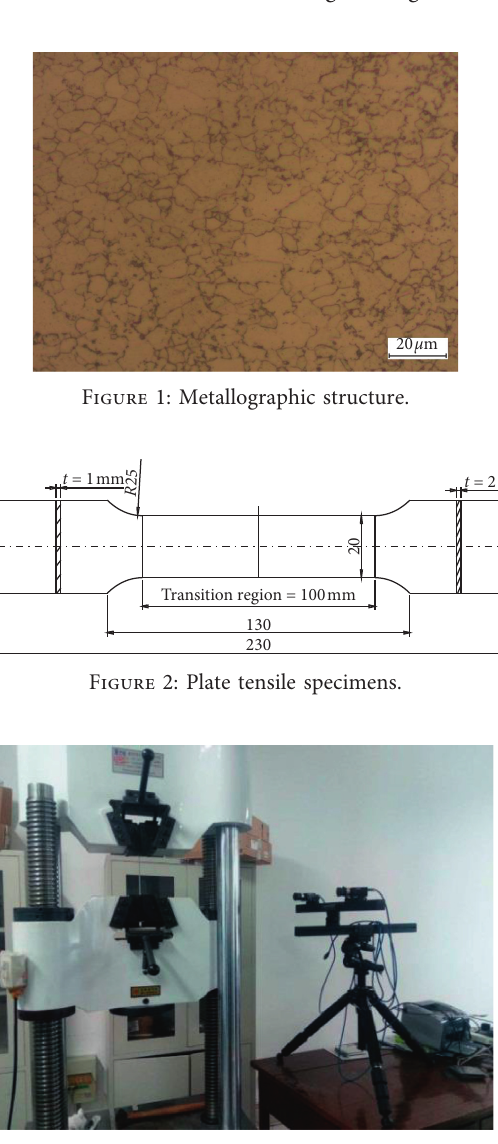
Figure 3: Universal tensile test machine coupled with DIC test equipment.